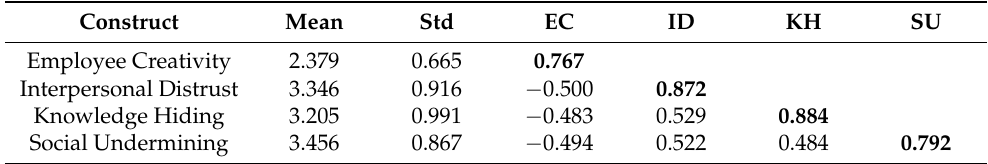
Table 2. Descriptive statistics and discriminant